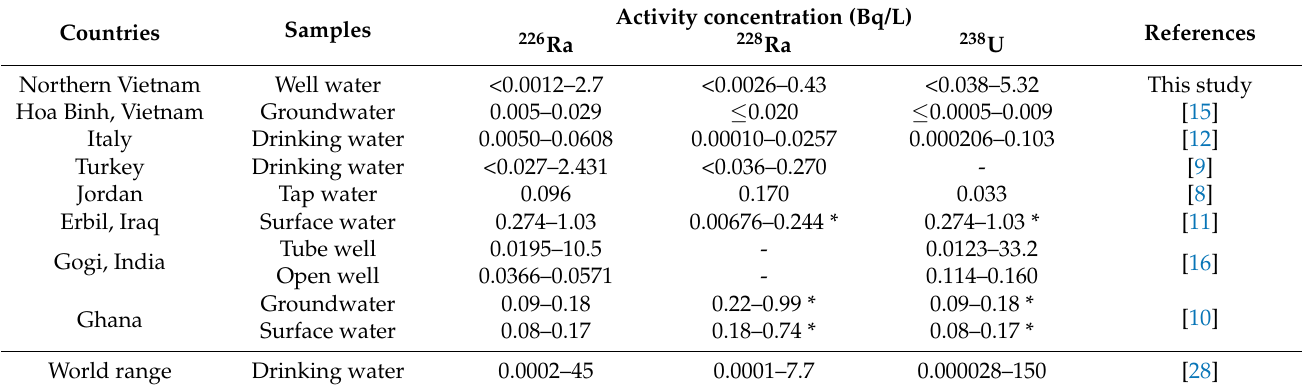
Table 2. 226 Ra and 238 U concentrations in water samples in different